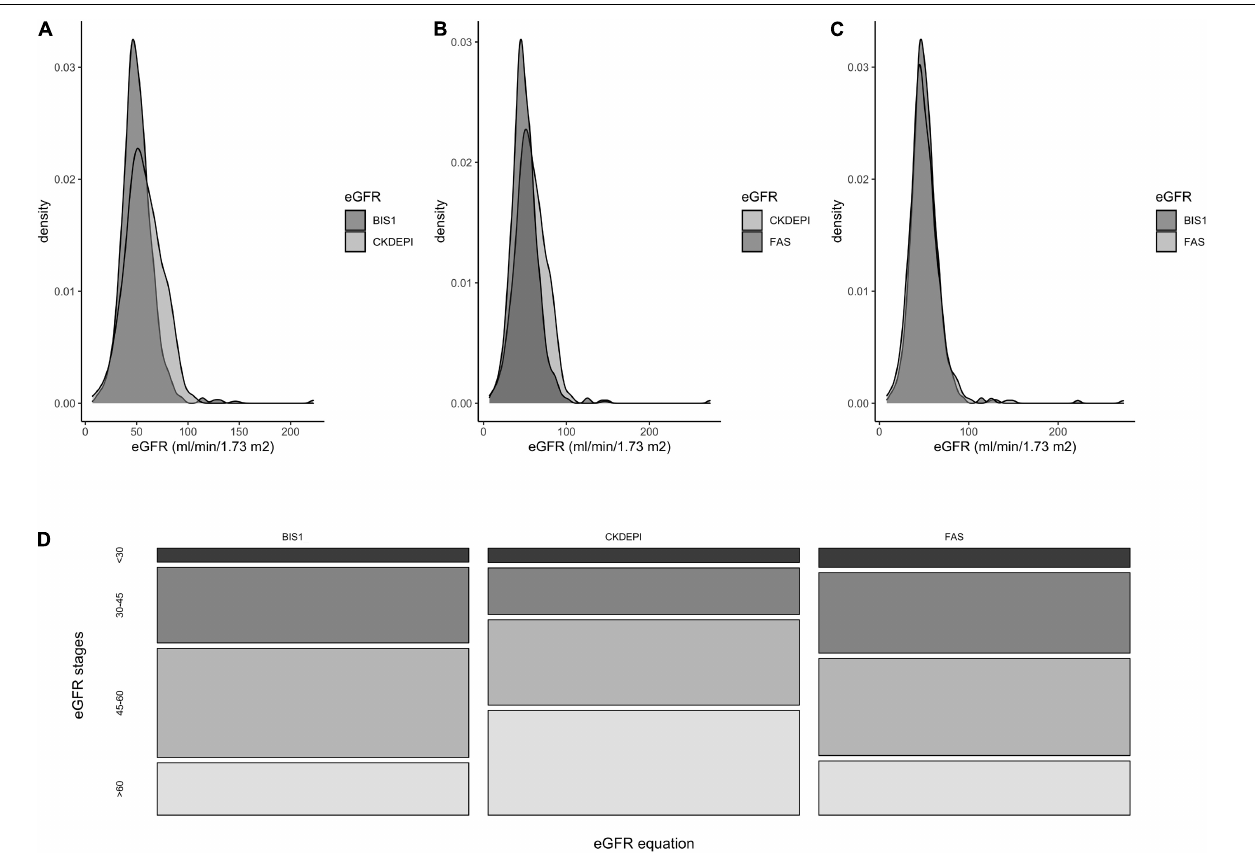
FIGURE 1 | Frequencies distribution of eGFR values according to three different creatinine-based equations. (A) comparison between BIS1 and CKD-EPI equations, (B) between CKD-EPI and FAS, (C) between FAS and BIS1. (D) Distribution of NH residents according to the eGFR stages obtained by three different equations.